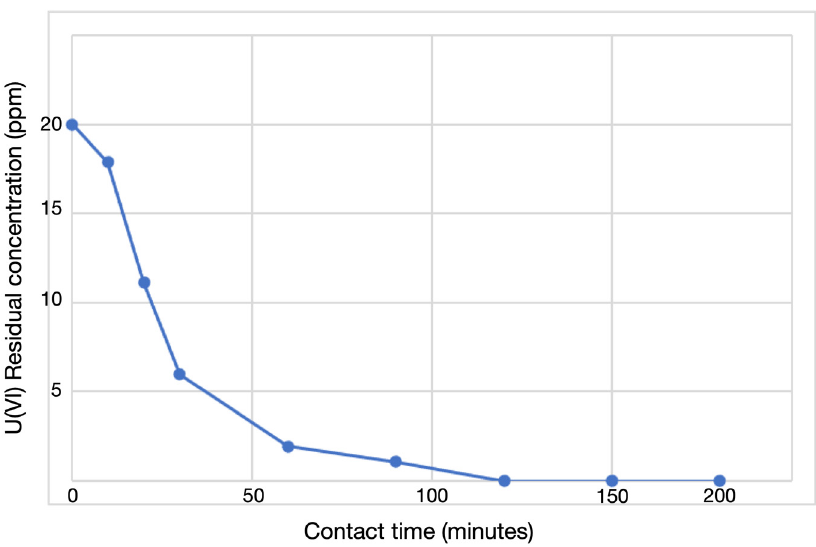
Figure 8. ICP-OES data of the supernatants collected after U(VI) adsorption on Phy@Fe 3 O 4